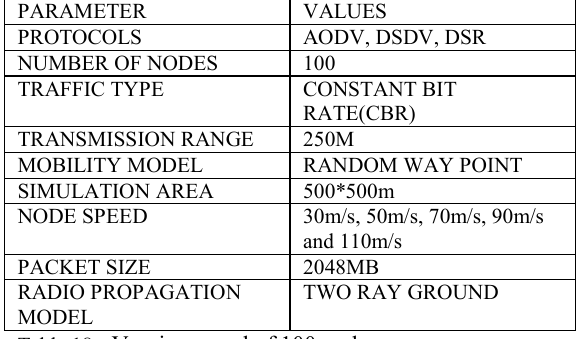
Table 18:- Varying speed of 100 nodes